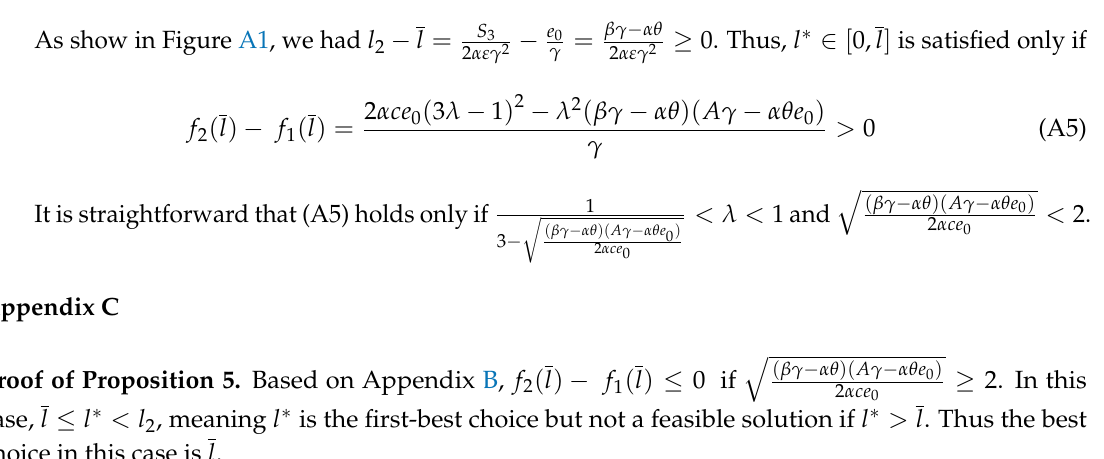
Figure A1. The curve of the function f 1 ( l ) or f 2 ( l ) in Sub-case A.1.